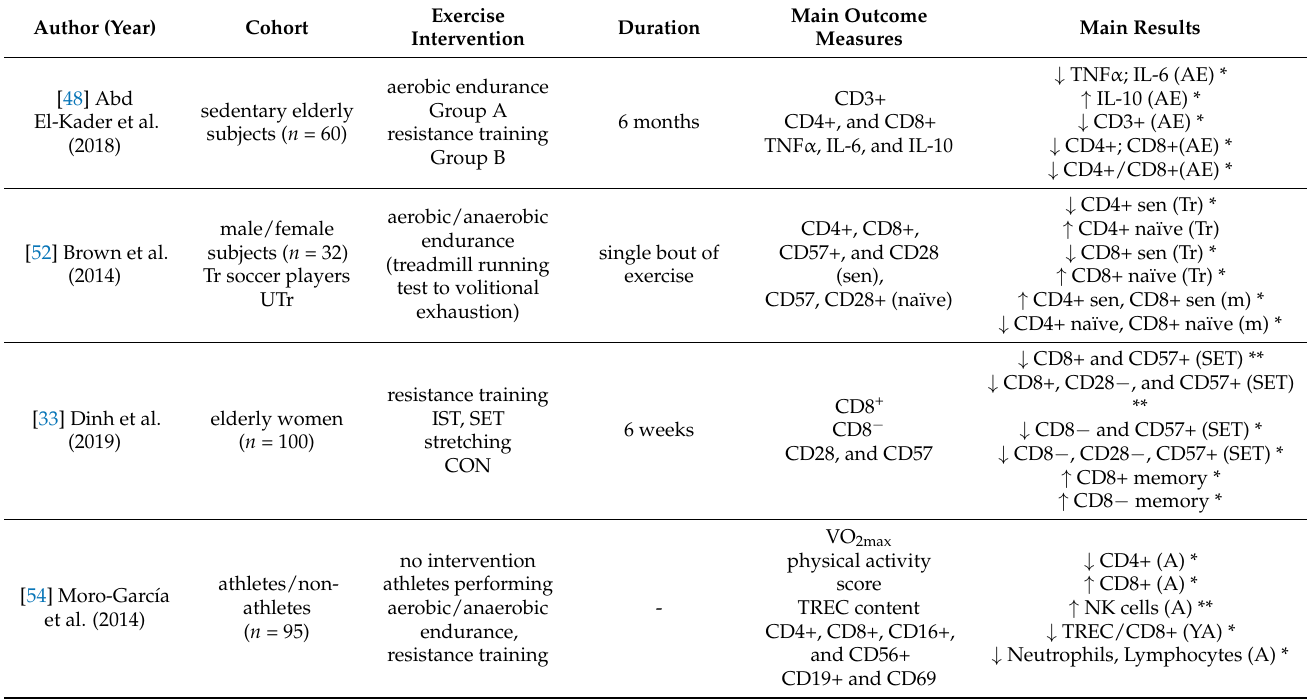
Table 7. Summary of studies outcome measures and main